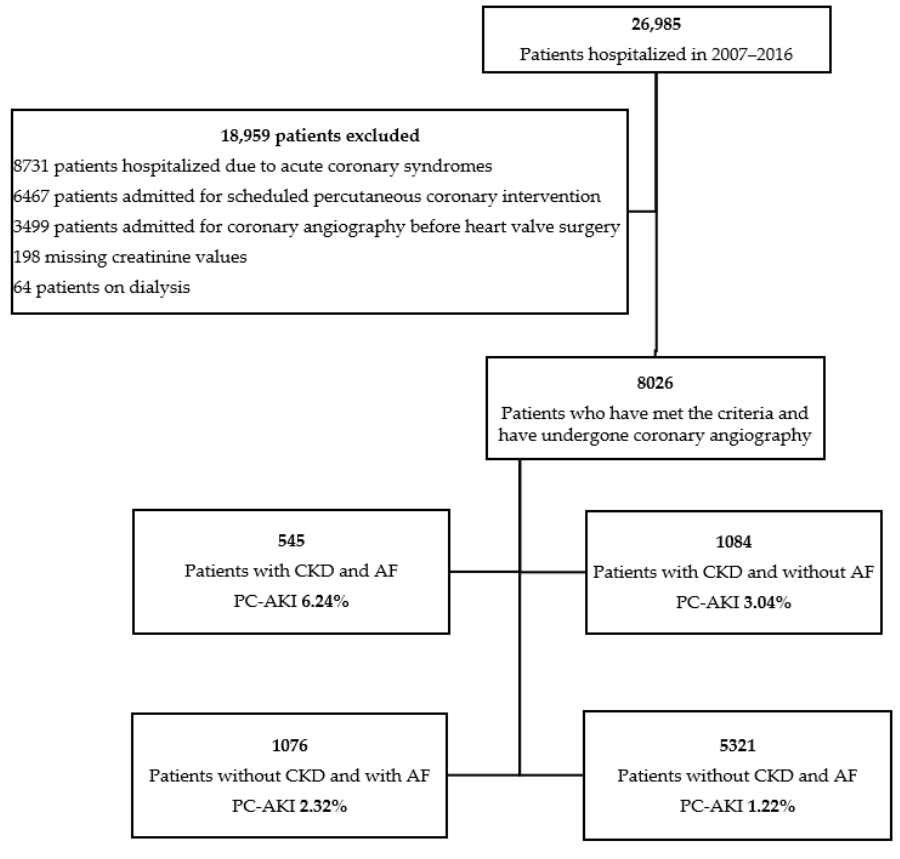
Figure 1. Selection of the study population.